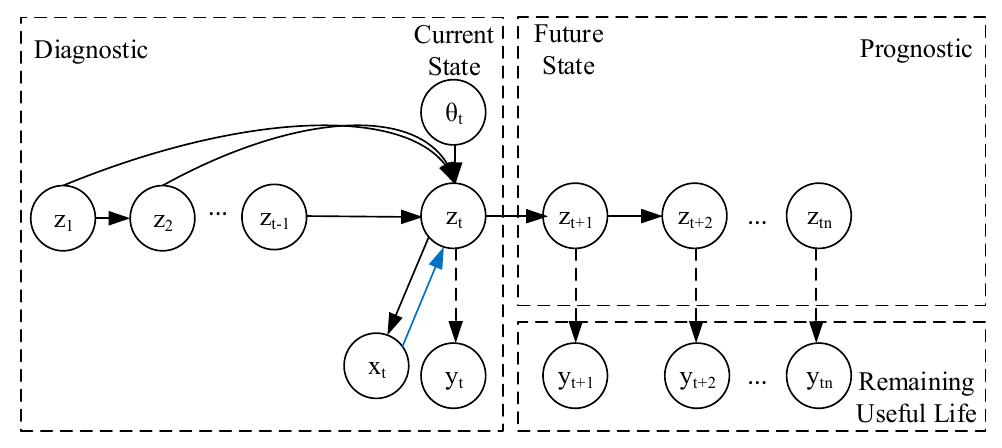
Figure 5. Forward graphical model for the proposed mathematical framework.